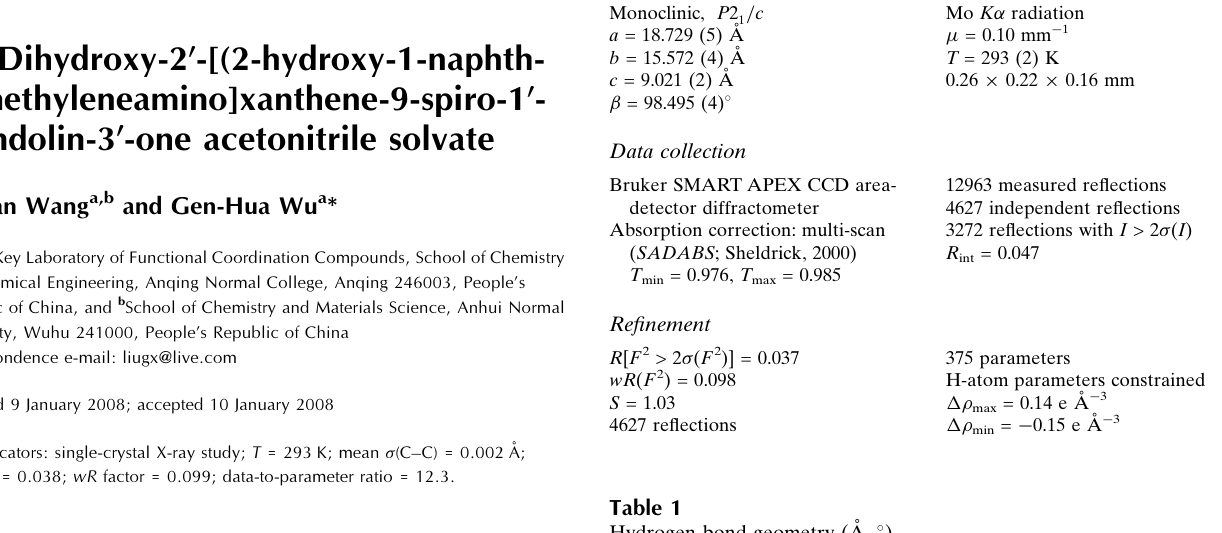
Hydrogen-bond geometry (A˚ , (cid:2)